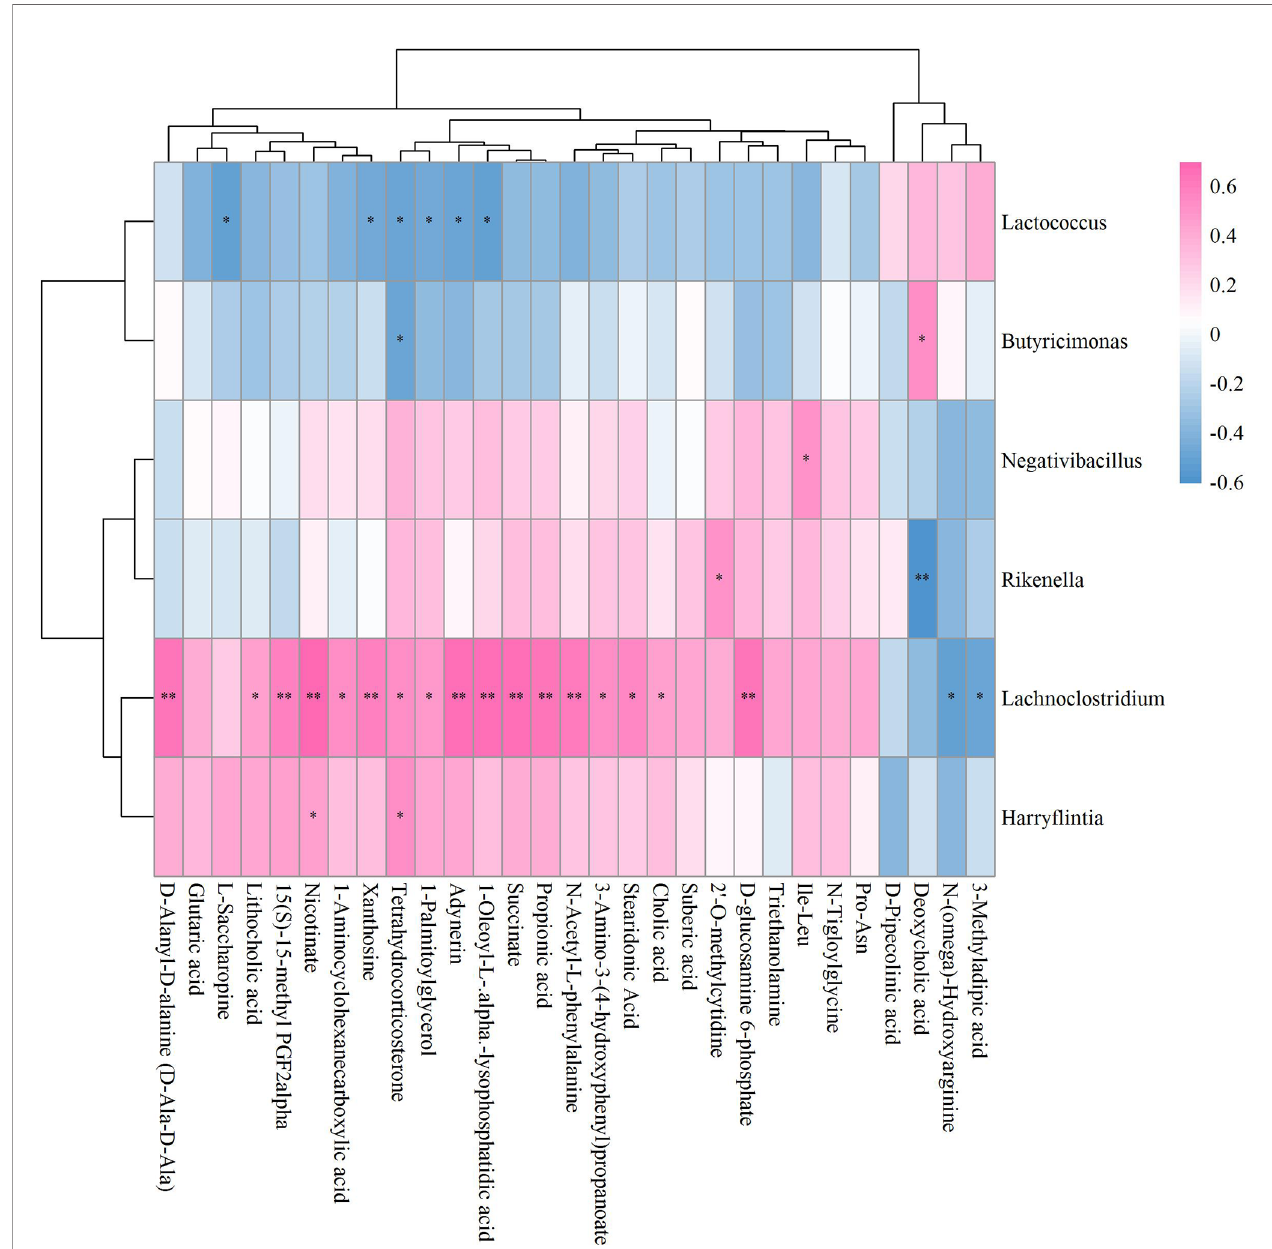
FIGURE 7 | Hierarchical clustering heat map of the signi fi cant differential GM and fecal metabolites in Sham and OVX groups based on Spearman correlation analysis (n = 10). * and ** mean a signi fi cant correlation between GM and fecal metabolites was found based on p < 0.05 and p < 0.01,